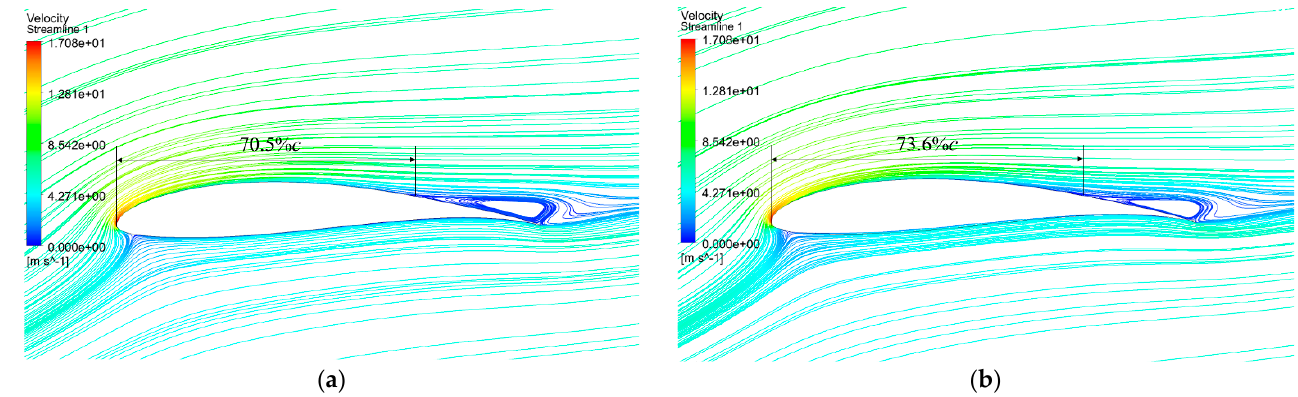
Figure 24. Streamline of 50% span wing section ( v = 6.4 m/s, α = 4°): ( a ) Rigid-skin wing; ( b ) Polyimide-skin wing.